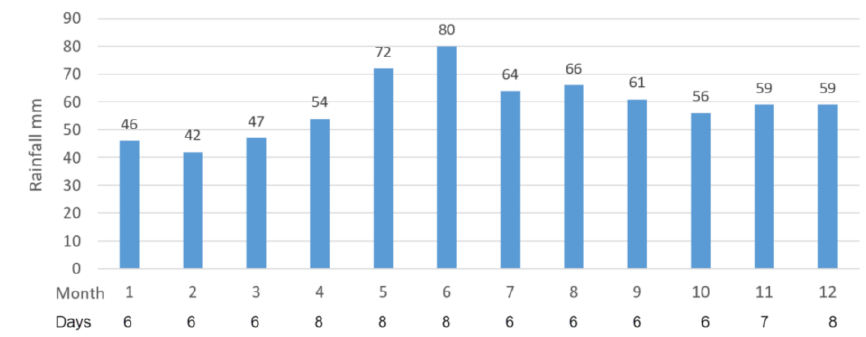
Figure 3. The average rainfall for Dragotin